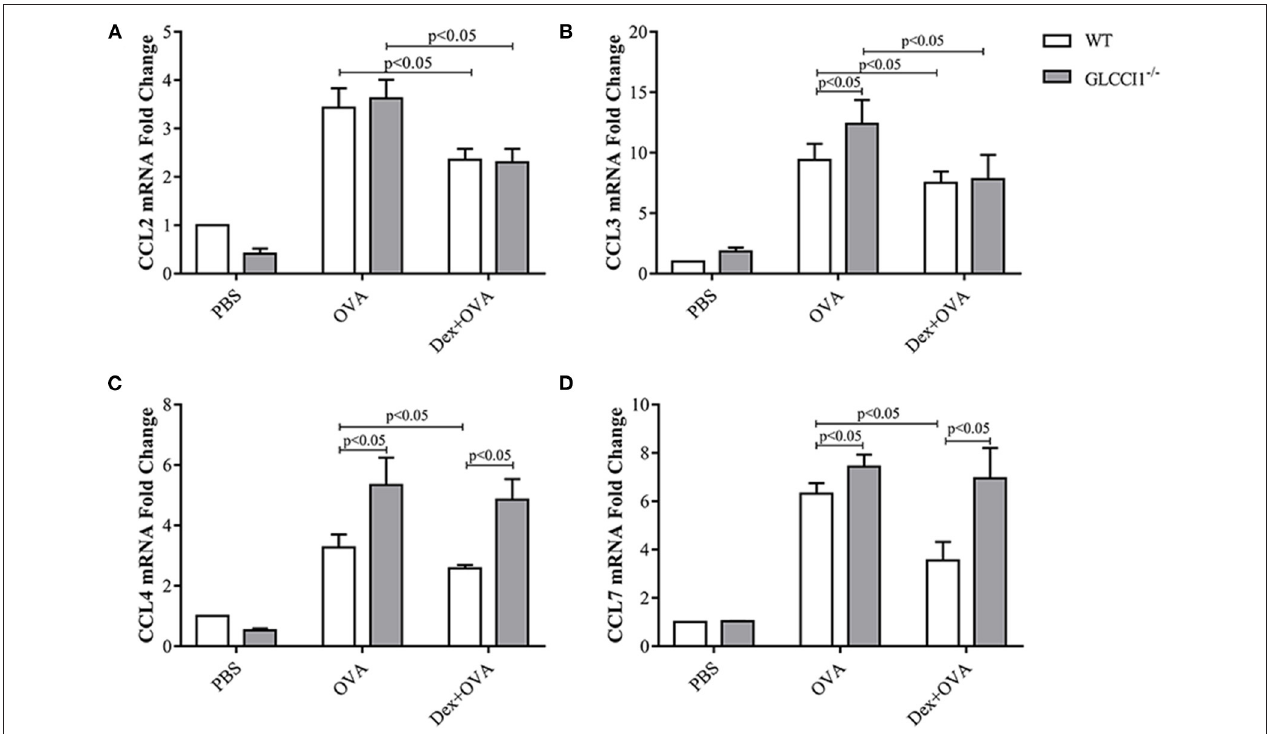
FIGURE 6 | GLCCI1 mediates chemokine dysfunction in OVA-induced asthmatic mice. RT-PCR analysis of CCL2 (A) , CCL3 (B) , CCL4 (C) , CCL7 (D) mRNA levels in lung tissues from mice in different groups. Data are presented as the mean ± SEM, n = 6 mice per group. Intergroup differences as determined one-way ANOVA followed by LSD